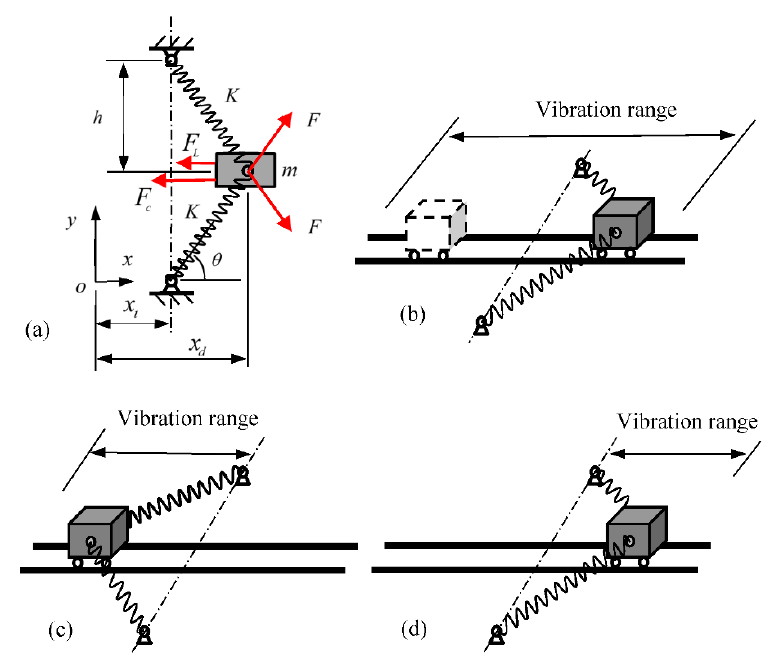
Figure 4. Analytical model and bi-stable vibration: ( a ) Bi-stable vibration model, ( b ) monostable vibration on right side, ( c ) monostable vibration on right side, and ( d ) bi-stable vibration.